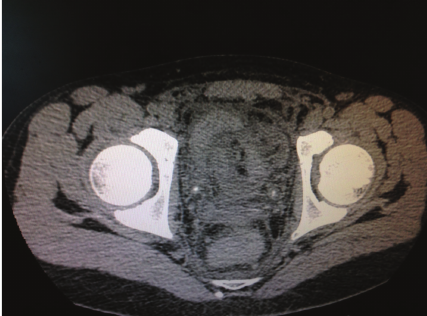
Figure 4: Stones on both distal